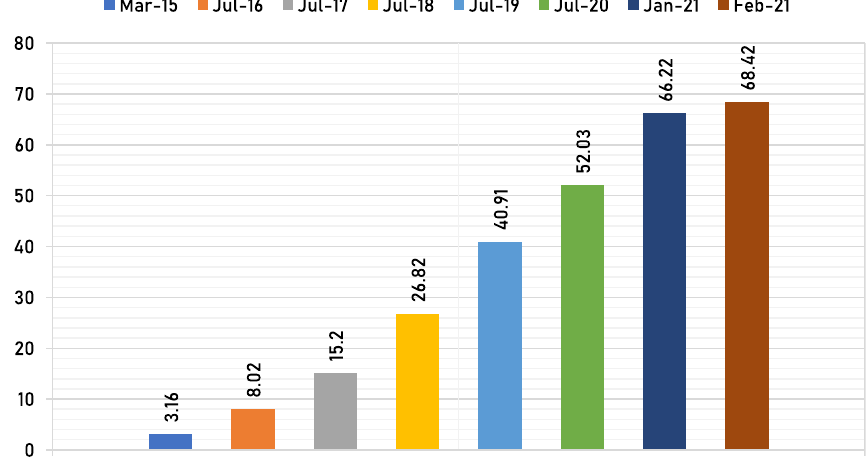
Fig. 1 Global blockchain wal- let usership from 2015 to